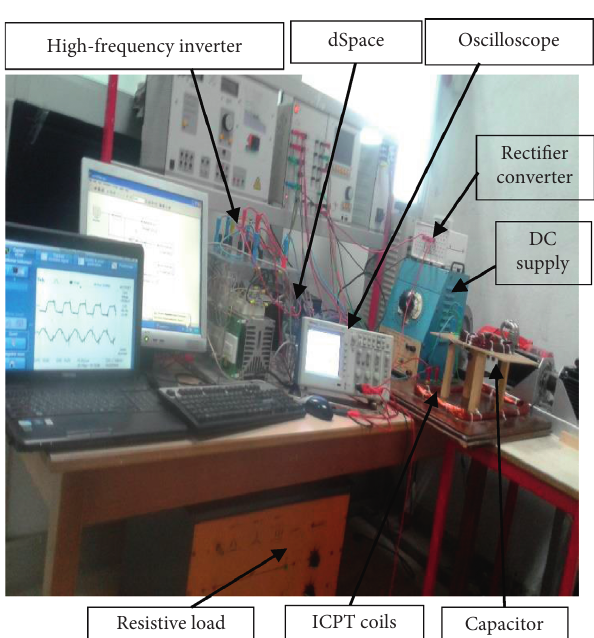
Figure 10: The experiment setup of the proposed wireless charging system.